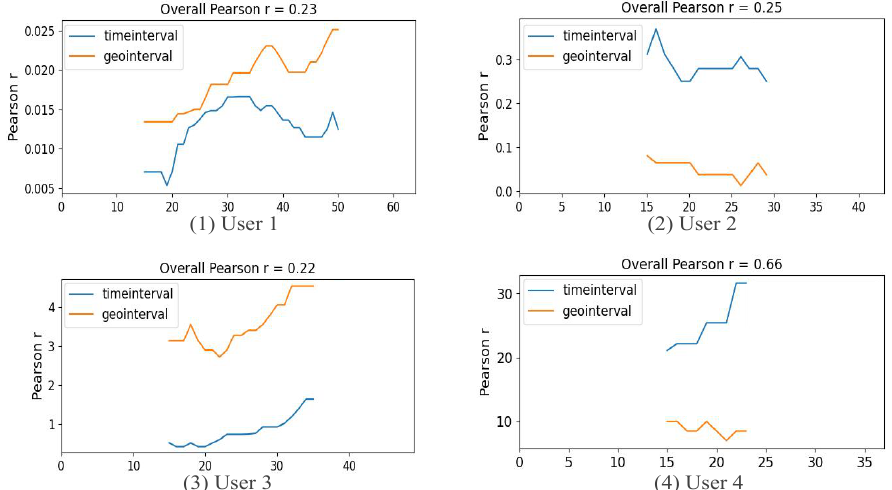
Figure 3. Illustrations of spatio-temporal unequal interval correlation in check-in sequences of different users from